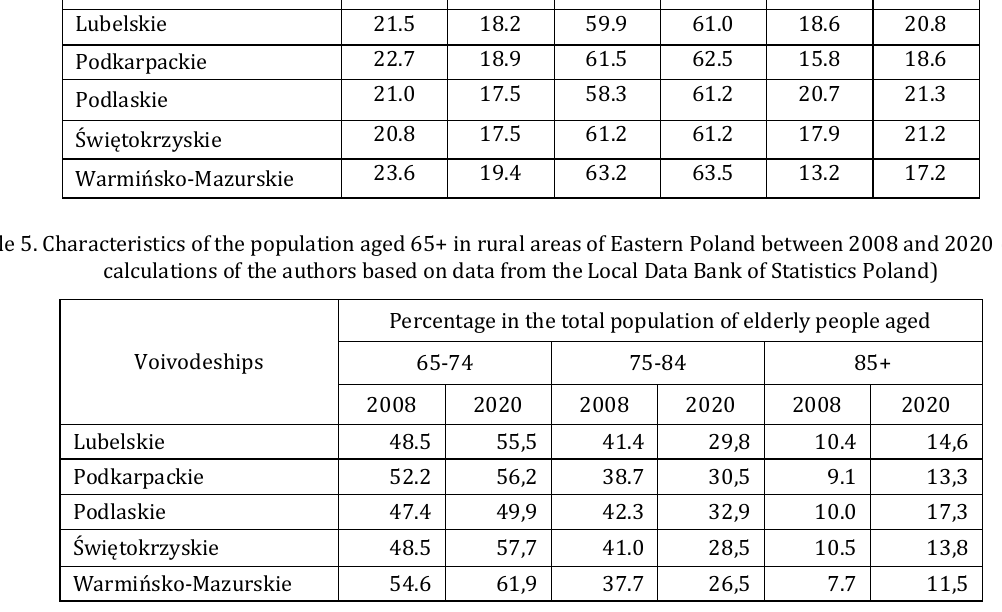
Table 4. Demographic structure of rural areas of Eastern Poland during the period 2008 to 2020 (Source: calculations of the authors based on data from the Local Data Bank of Statistics, Poland) Pre-working age Voivodeships